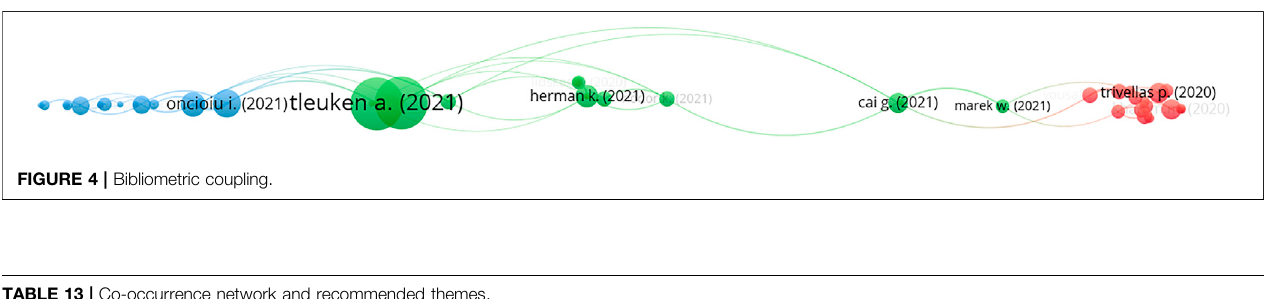
TABLE 13 | Co-occurrence network and recommended